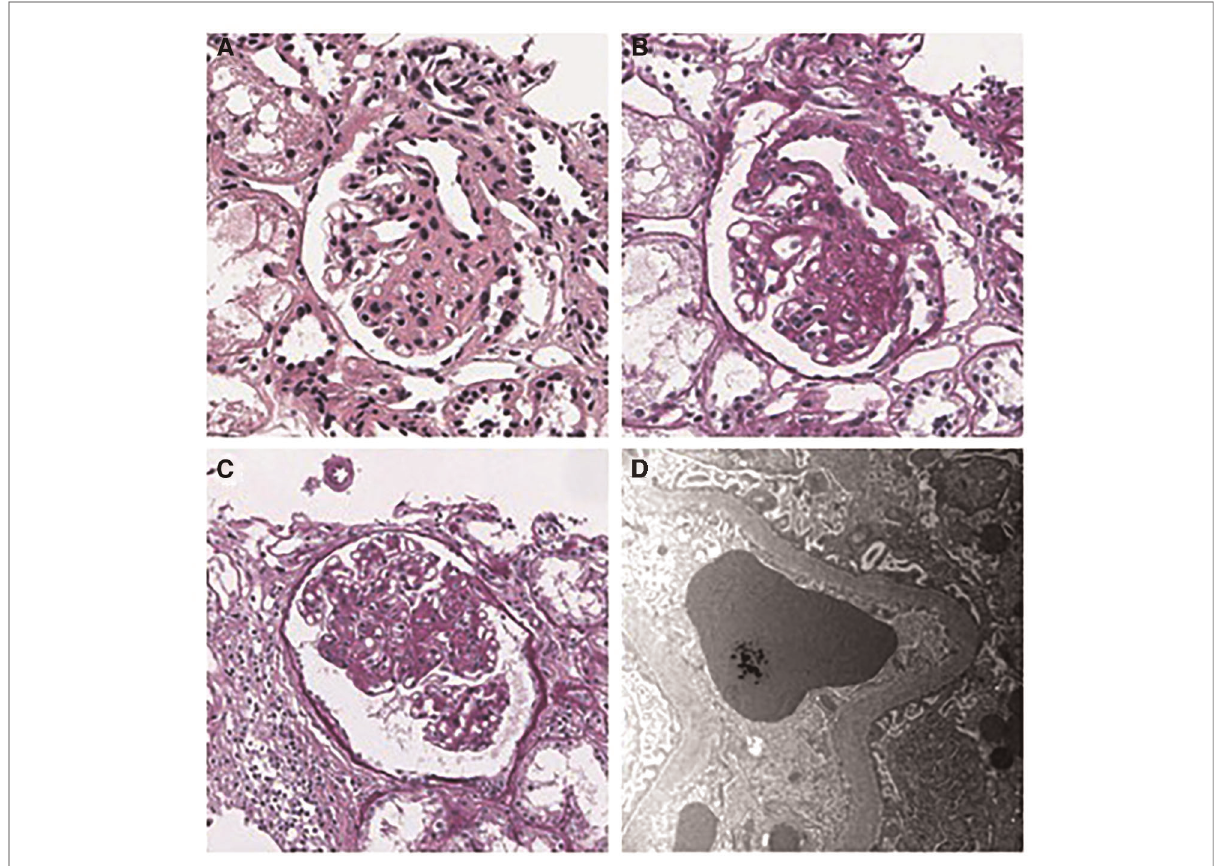
FIGURE 1 Kidney biopsy fi ndings. ( A – B ) H&E and PAS staining show segmental sclerosis at the vascular pole of the glomerulus. The patient was diagnosed as having focal segmental glomerulosclerosis, perihilar variant. ( A ) H&E stain,×400, ( B ) PAS stain,×400). ( C ) Mild endocapillary hypercellularity and glomerular enlargement was observed in other glomeruli, with a maximum diameter of 302 μ m. (PAS stain,×250). ( D ) Electron microscopy showing mild effacement of foot processes.